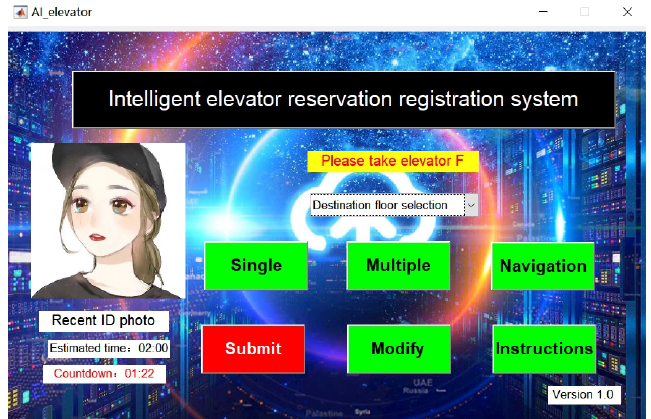
Figure 1. The main interface of reservation elevator APP.